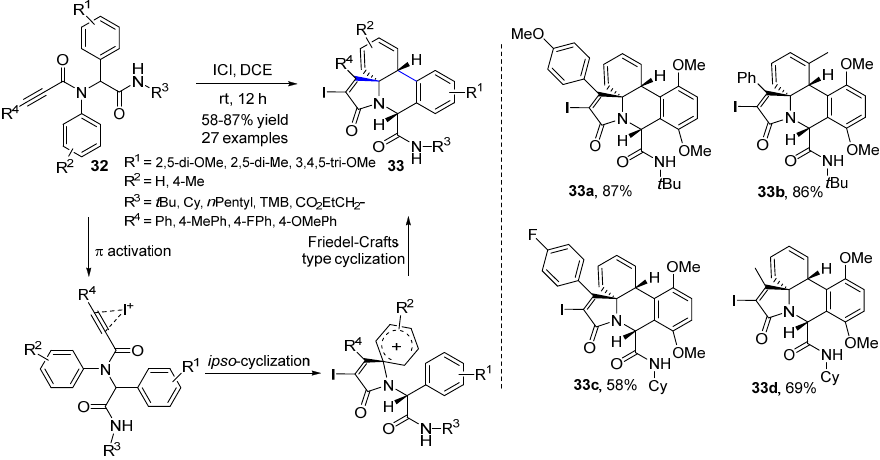
Scheme 17. Palladium ‐ catalyzed dearomatization/aza ‐ Michael